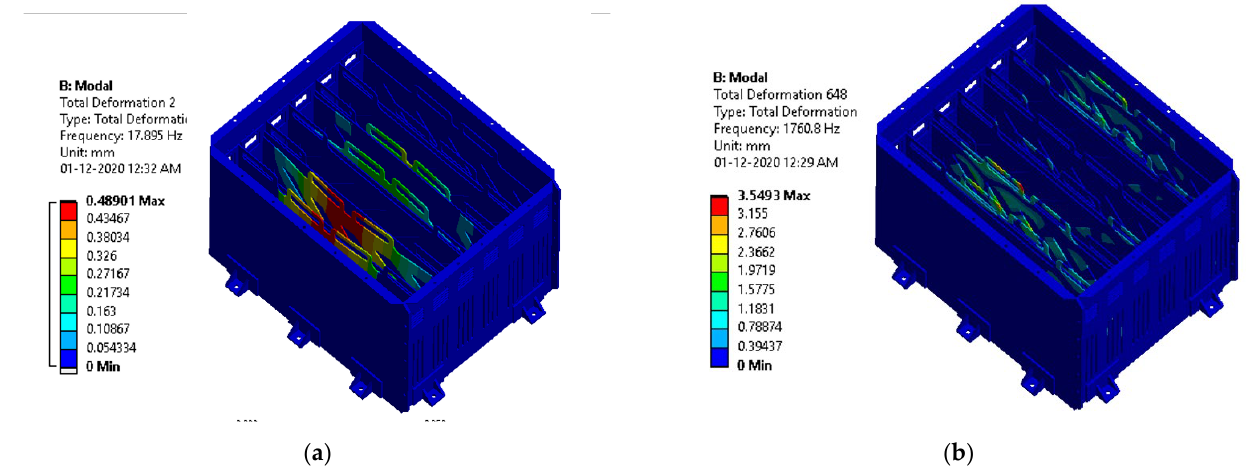
Figure 17. ( a ) Minimum deformation for modal analysis at 17.895 Hz frequency is 0.489 mm. ( b ) Maximum deformation for modal analysis 1760.8 Hz frequency is 3.5 mm.